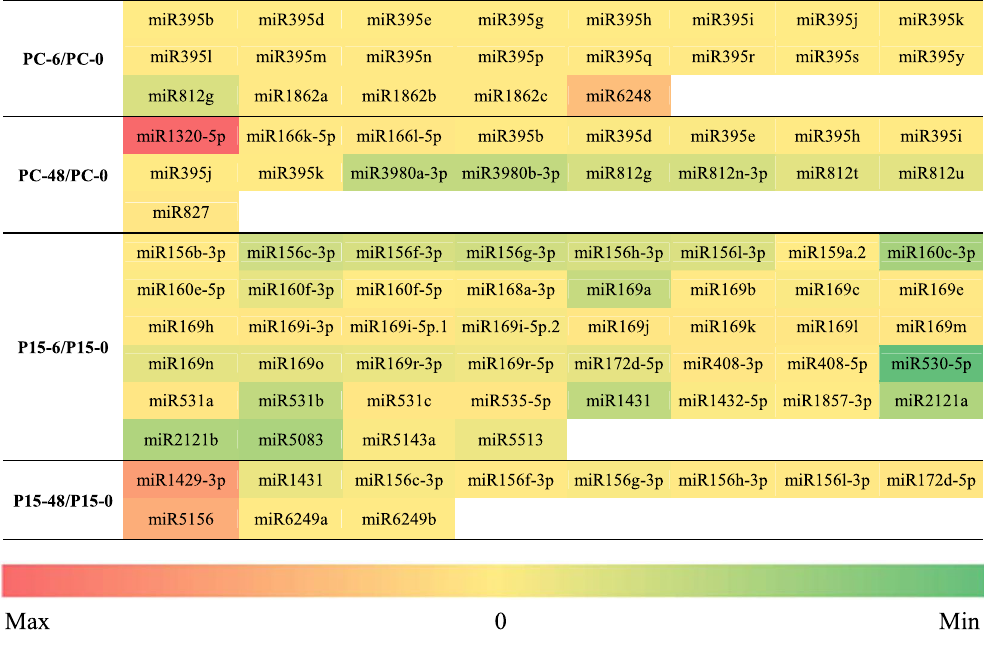
Table 4. Differentially expressed miRNAs that belong to different families at 6 h and 48 h after BPH feeding. The colors represent the fold-change values of the corresponding